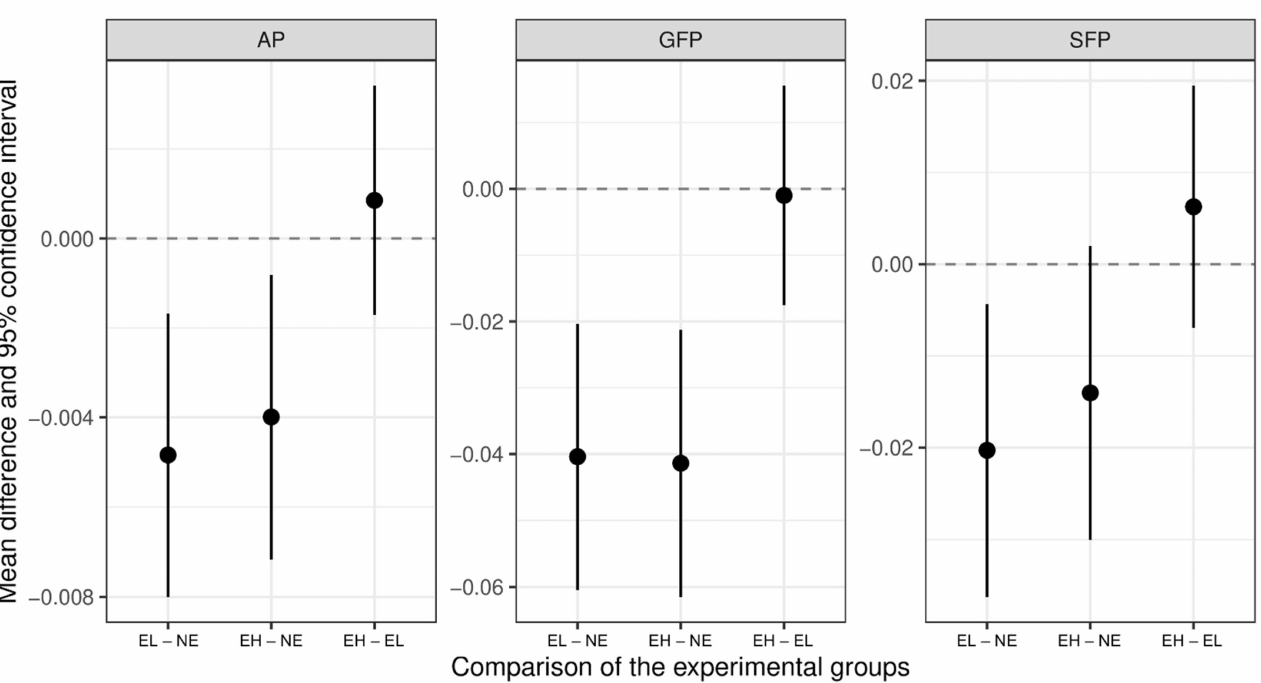
Figure 2. Estimated effects of the experimental group on the occurrence of pecking behavior. The diagram shows the estimated effect and 95% confidence intervals (CI) of the experimental group (EG) on the occurrence of gentle feather pecking (GFP), severe feather pecking (SFP), and aggressive pecking (AP). Results were considered significant when the CI did not include zero. Estimated effects above zero indicate an increase in the chance of observing a behavioral parameter, whereas estimated effects below zero indicate a decrease. Experimental groups: NE (not enriched, high stocking rate), EL (enriched, low stocking rate), EH (enriched, high stocking